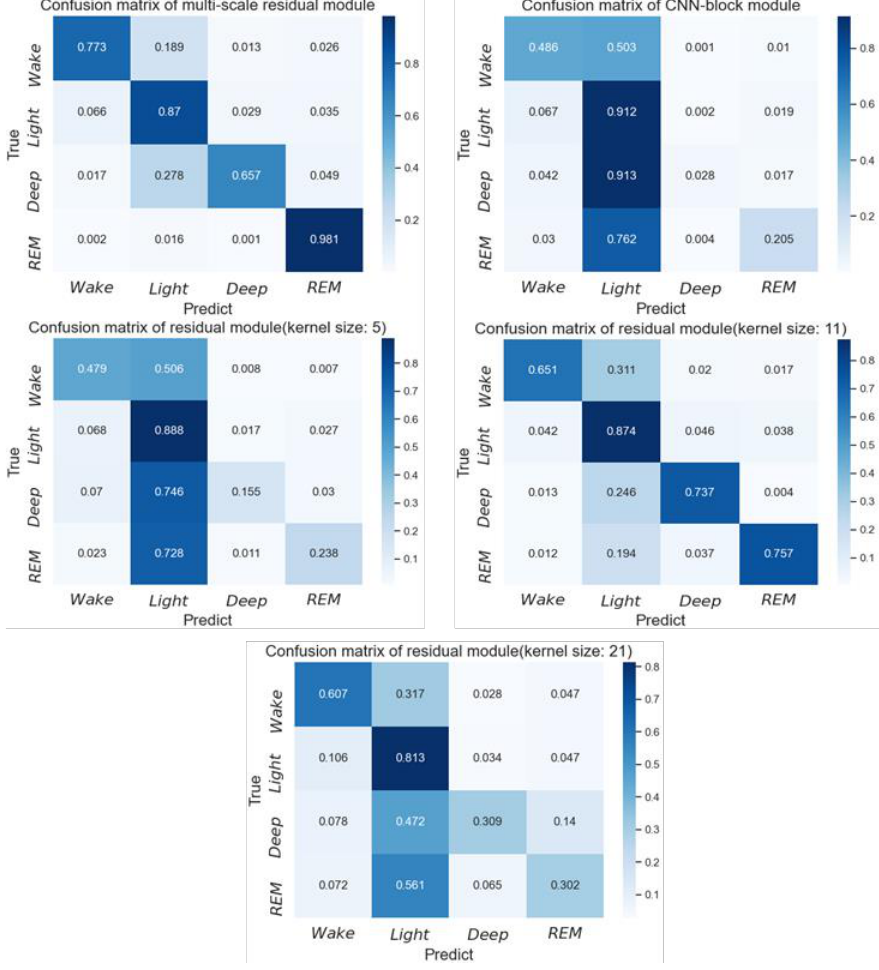
Figure 8. Confusion matrix of the subject-specific sleep stage classification under the cross-dataset